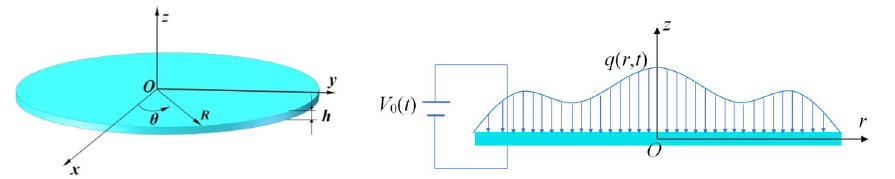
Figure 1. Schematic of axisymmetric flexoelectric circular